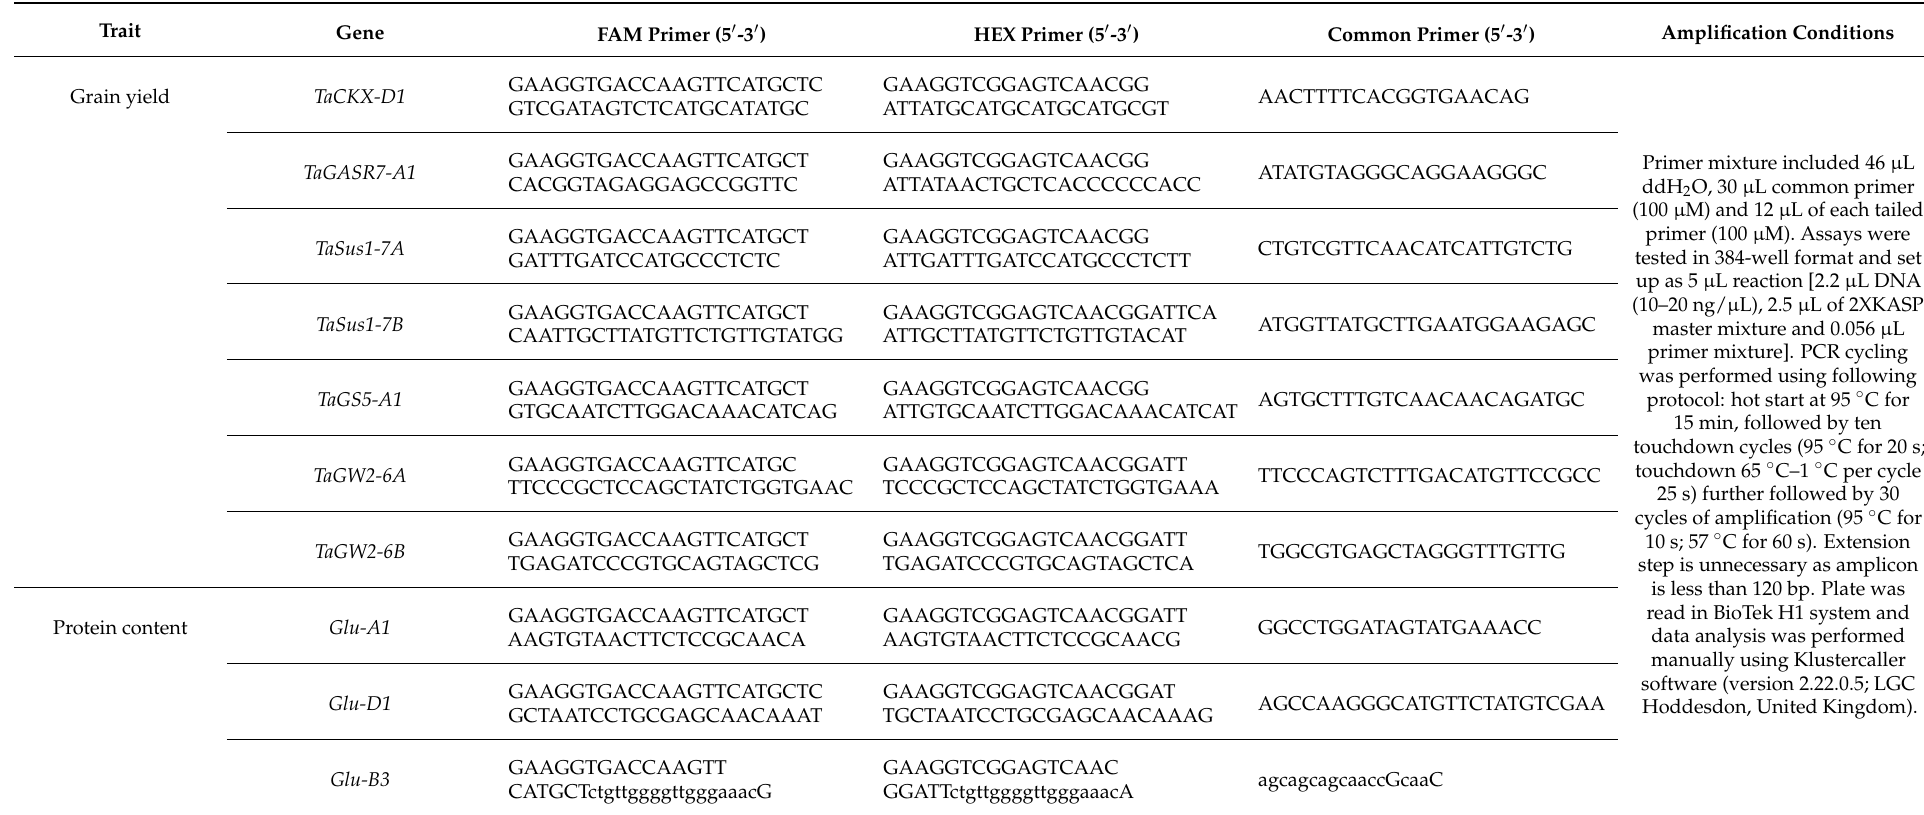
Table 1. The primer sequences and the amplification condition of each